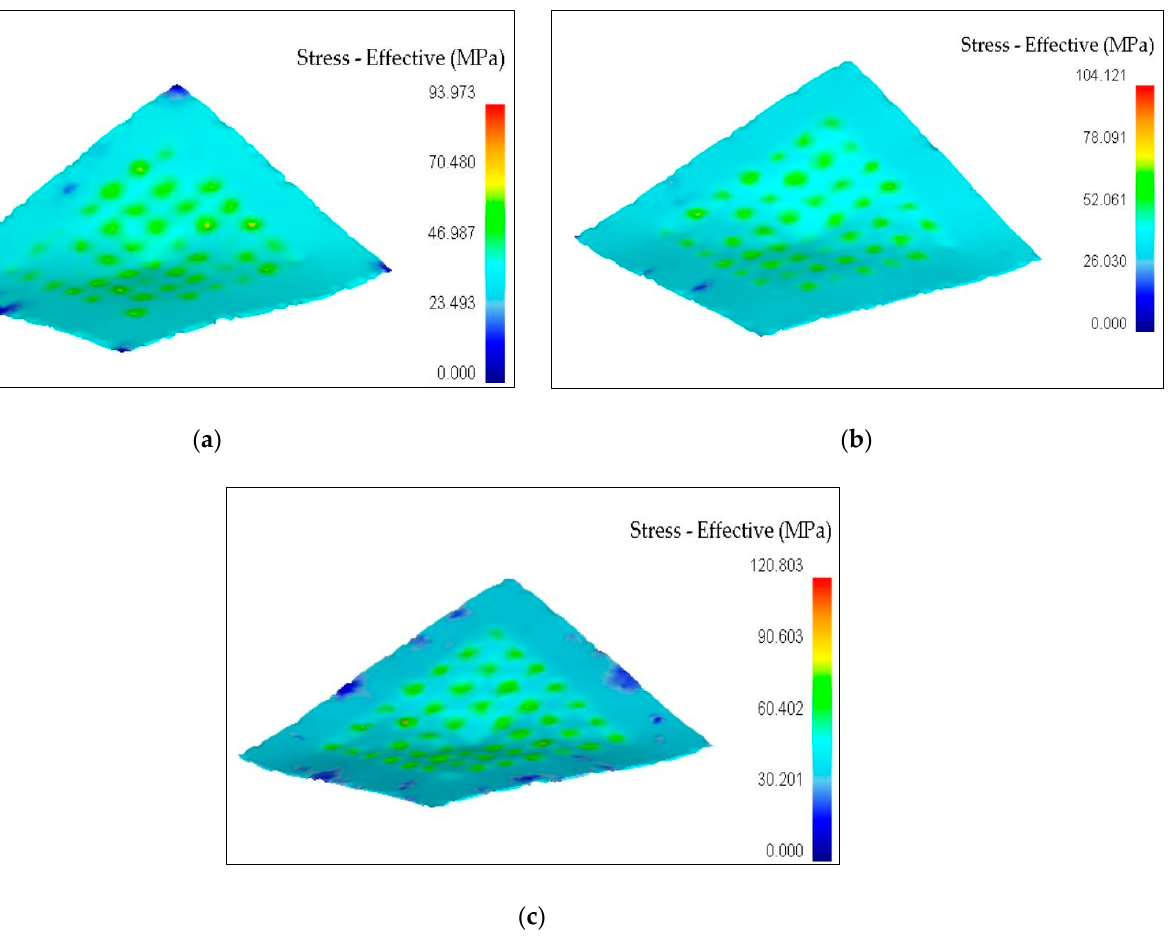
Figure 10. Effective Stress Distribution of form3 with a pin diameter of ( a ) 10 mm; ( b ) 12 mm; ( c ) 14 mm.